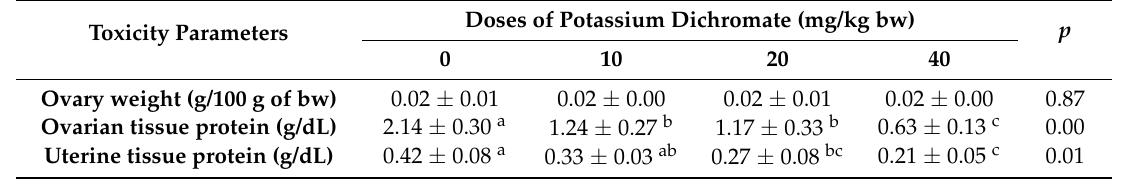
Table 4. Effects of potassium dichromate on ovary weight and tissue proteins in rabbit doe. Toxicity